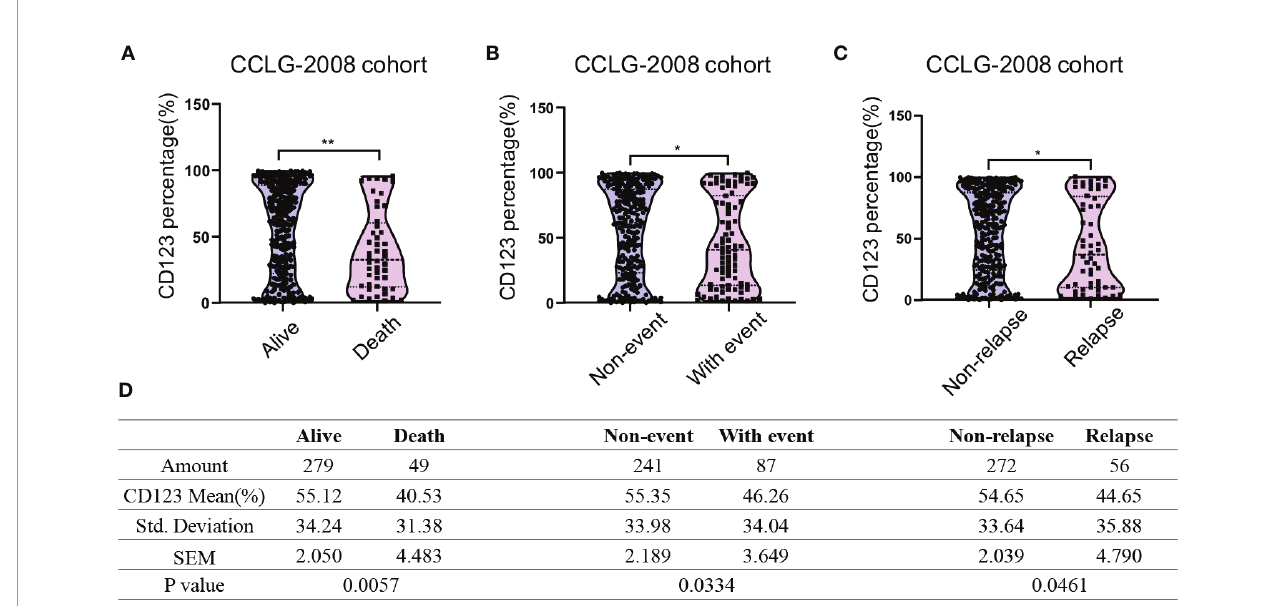
FIGURE 1 | Pediatric B-ALL with favorable clinical outcomes displayed high CD123 expression in the CCLG-ALL-2008 cohort. Comparison of CD123 expression in leukemic blasts between survivors and non-survivors (A) , event-free and with-event patients (events including drug resistance, treatment abandonment, relapse, and HSCT) during treatment (B) , and relapsed or non-relapsed B-ALL (C) in the CCLG-ALL-2008 cohort; (D) Detailed amounts of patients and mean CD123 percentage in each group from A to C *p < 0.05; **p <